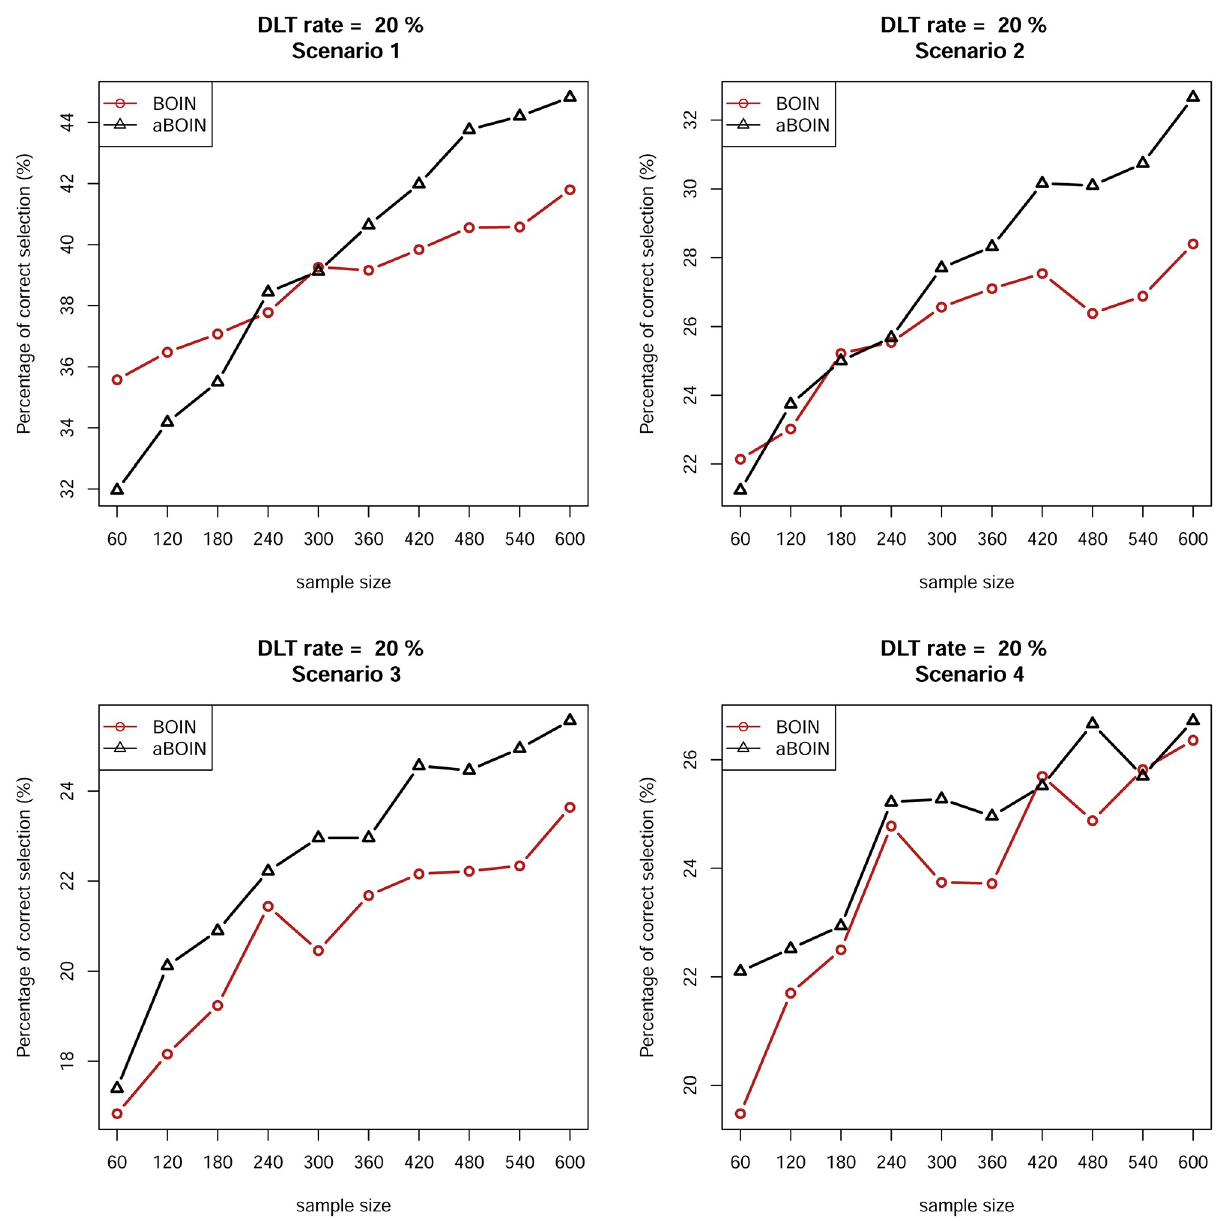
Fig 3. Percentage of correctly selection percentage of MTD of the first four scenarios on the left panel (DLT rate 20%) in Table 2 by using the two competing methods BOIN and aBOIN with a large sample.